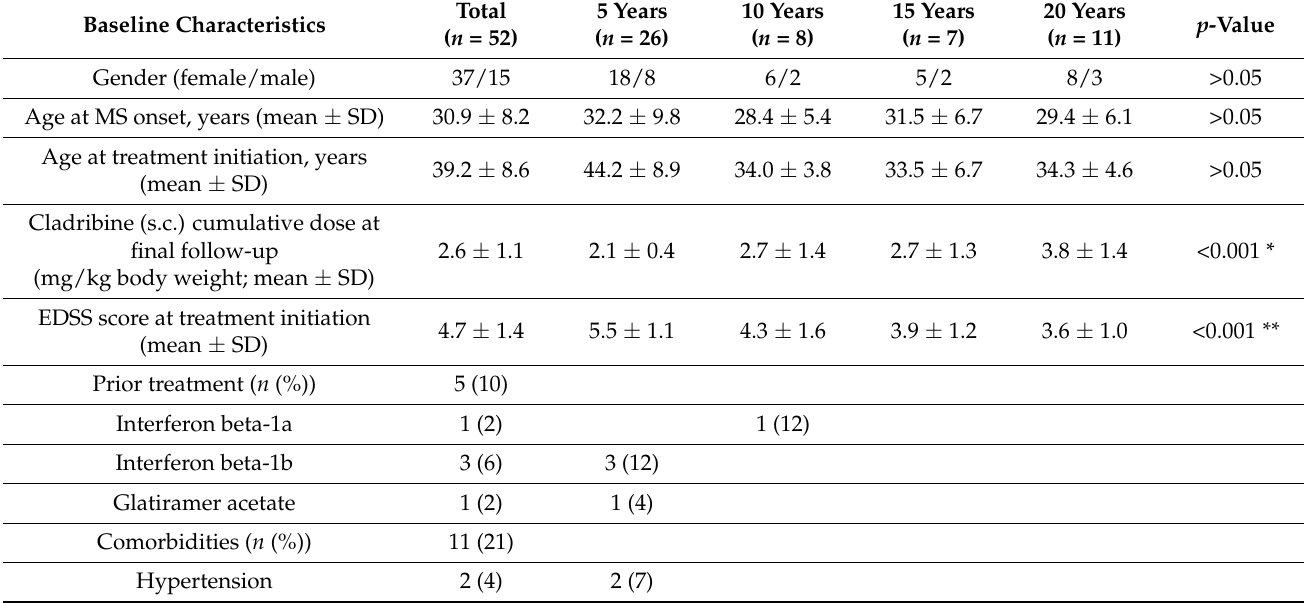
Table 1. Baseline characteristics of patients according to duration of